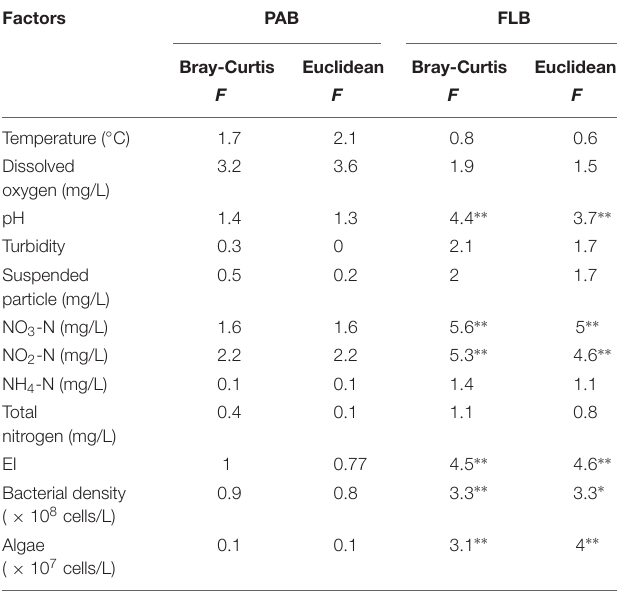
TABLE 2 | Correlation between factors and bacterial communities based on Adonis (permutational multivariate analysis of variance using distance matrices). Factors PAB FLB